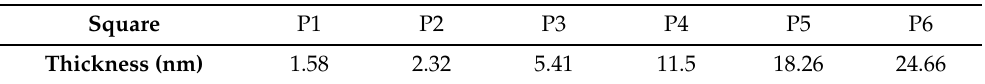
Figure 4. ( a ) Red squares in the density plot correspond to the small pieces of the sample where their magneto-optical effects were measured in this work. Those pieces are numbered in the text as P1 to P6 from A to B position, respectively. ( b ) Axes and angle diagrams refer to the used definitions along the text for the angular dependence of magneto-optical effects in our Co nanocluster assembly. Table 1. Table indicates t values in respective square pieces used in the following characterization of magneto-optic effects. These values have been extrapolated from the measured thickness profile of the Co nanocluster assembly (see Figure